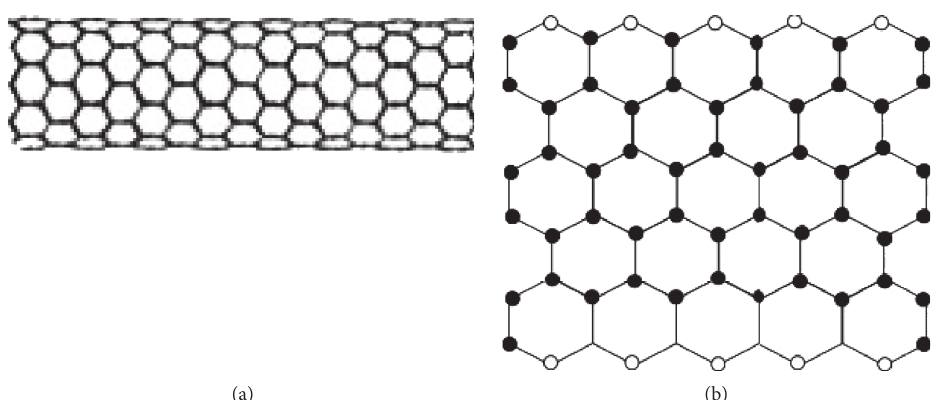
Table 4: The cardinalities of the faces with given degree for given number of rows.